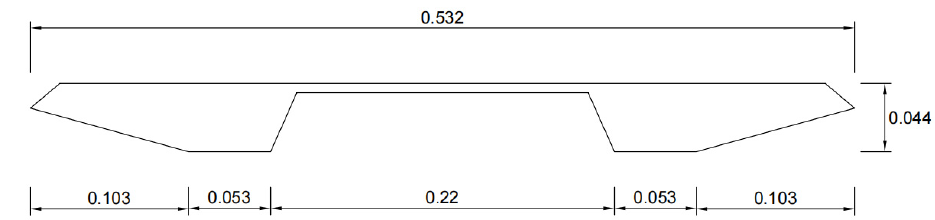
Figure 1. Deck section dimensions and shape (m).